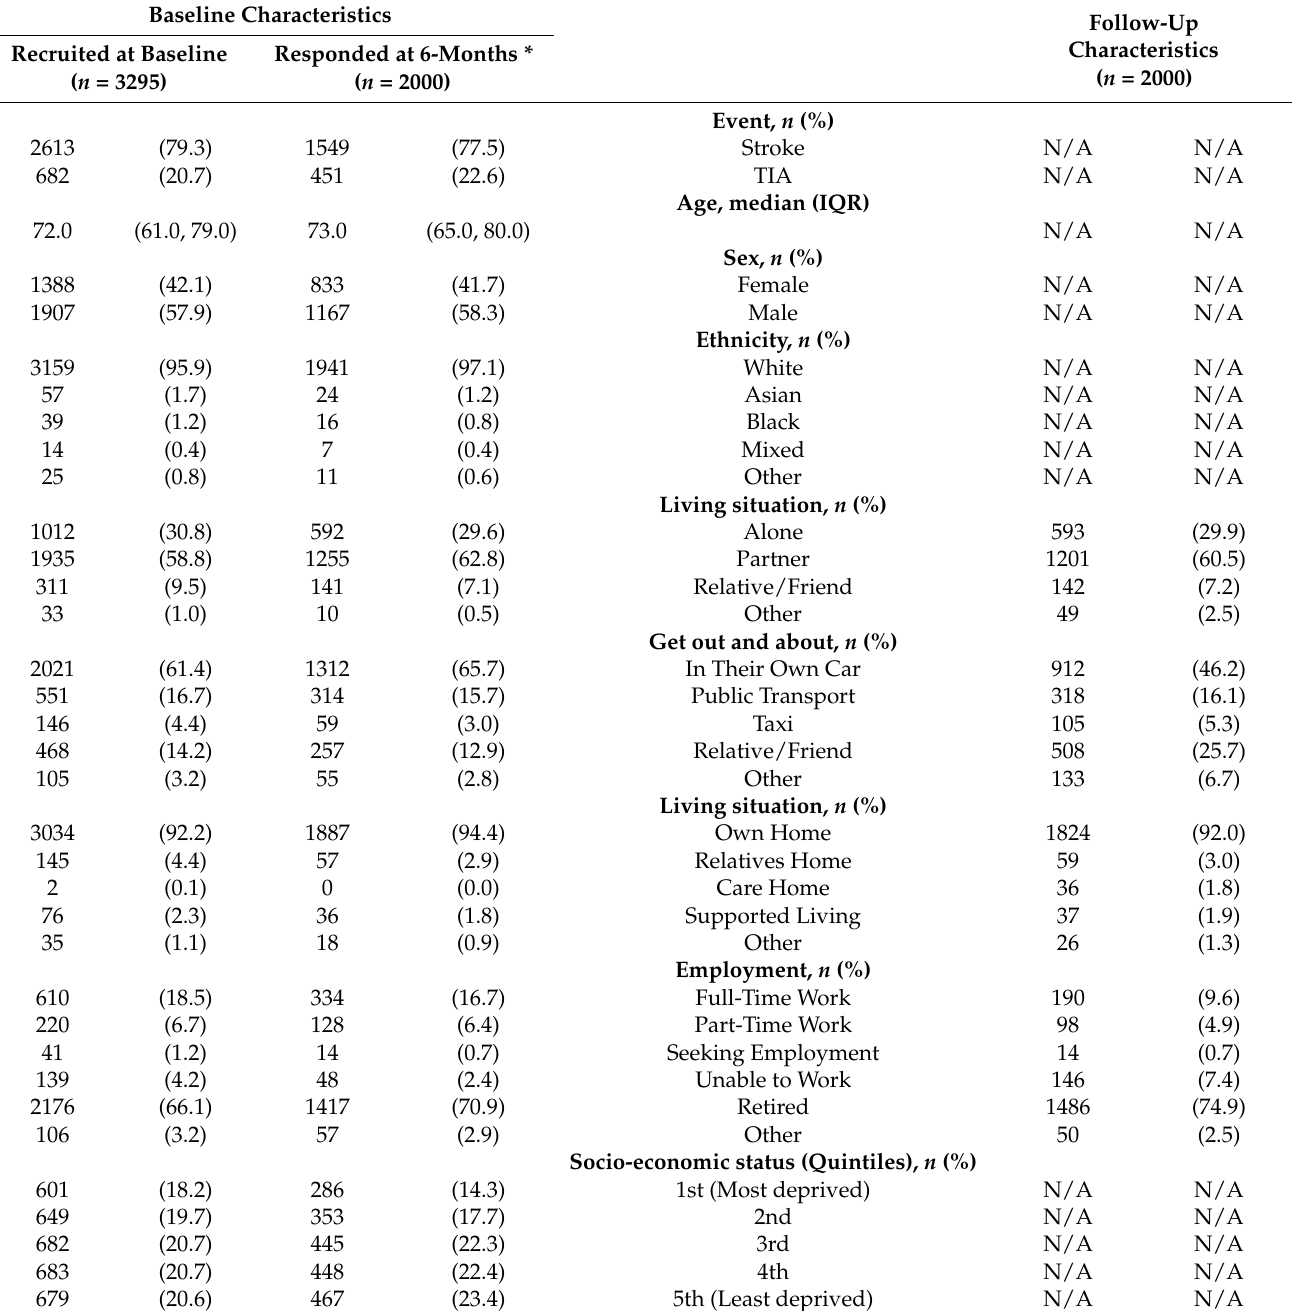
Table 1. Baseline characteristics and demographics for participants analysed at baseline, 6-months and the 6-month